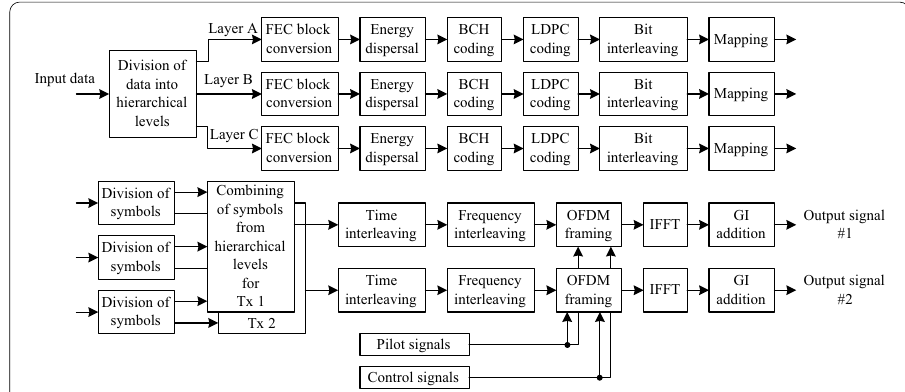
Fig. 2 Basic configuration of channel coding of advanced ISDB-T